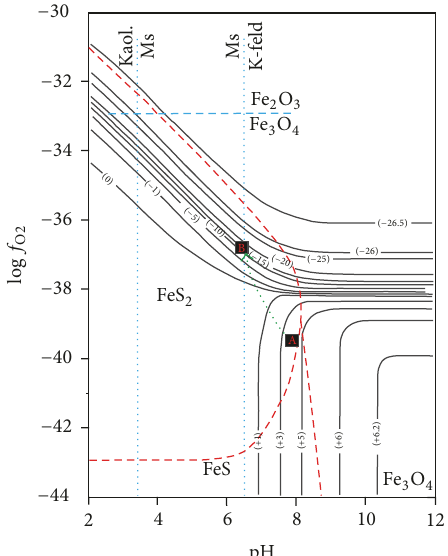
Figure 15: log 𝑓 O 2 versus pH isothermal diagram showing stability relationships in the system Fe-O-S for early and main stage (A) and late stage (B) of the paragenesis (modified from [38]). Given Fe- O-S mineral boundaries at Σ S = 0.1 moles/kg H 2 O, 𝑇 = 250 ∘ C, and 𝐼 = 1.0 condition, thinner red lines represent the stability field boundaries for pyrite, pyrrhotite, magnetite, and hematite with the following reasons: (1) the sulfur isotopic equilibrium temperatures are estimated to be 237–267 ∘ C; (2) previous study shows that pH value of the ore-forming fluid is near-neutral pH [19]; (3) the sericitization occurs in the Zhijiadi deposit. Kaol, kaolinite; Ms, muscovite; K-feld, K-feldspar.